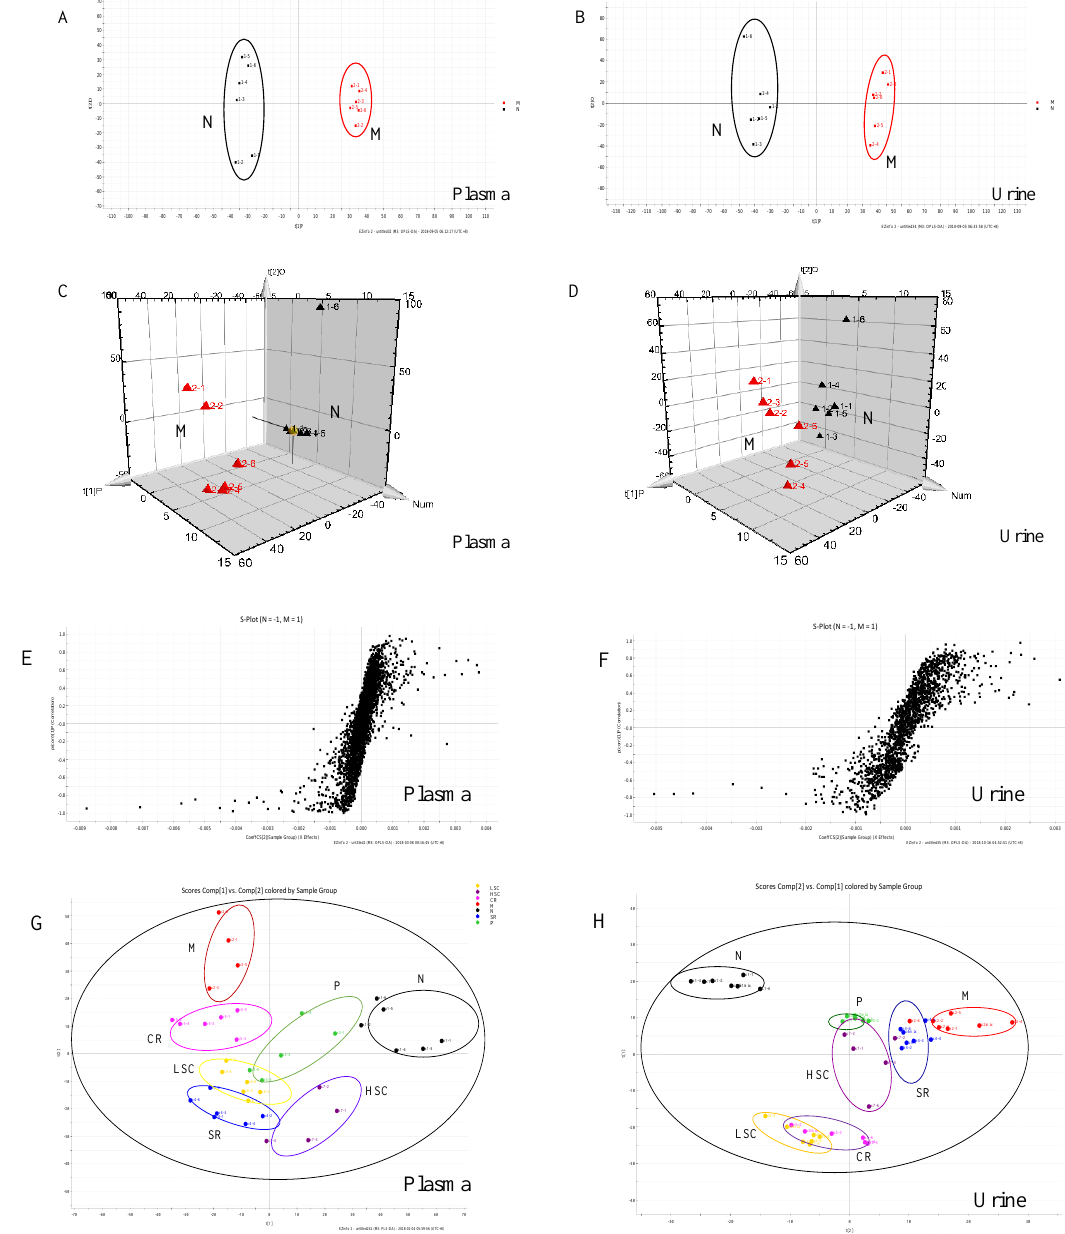
Figure 8. PCA model results between normal (N) and T2DM (M) rats in positive mode (( A ) 2-D plot of plasma; ( B ) 2-D plot of urine). 3D PLS-DA scores plot of LC-MS spectral data (( C ) plasma; ( D ) urine). S-plot of OPLS-DA model for M vs. N group (( E ) plasma; ( F ) urine). PCA analytical results from N and M rats treated with metformin (P), scutellaria Radix (SR), coptidis Rhizome (CR), low dose of combined extracts group (LSC) and high dose of combined extracts (HSC) at positive mode (( G ) plasma; ( H ) urine).